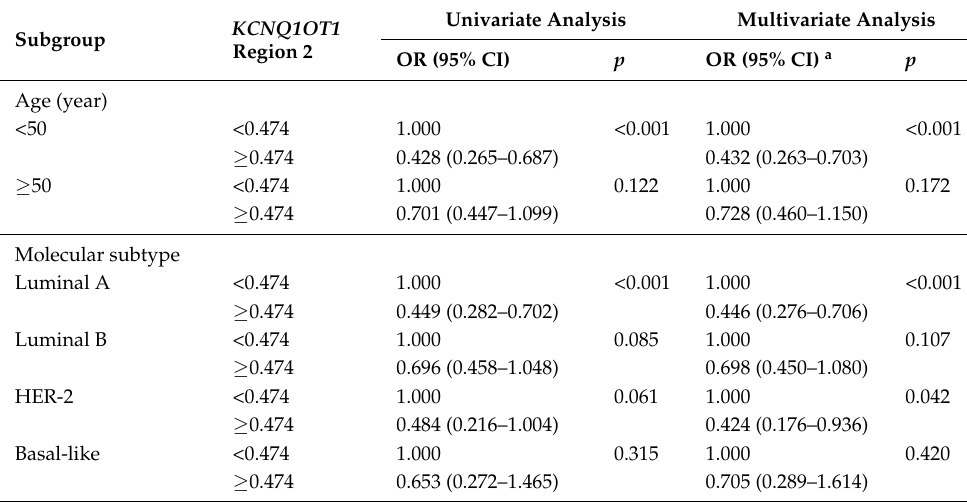
Table 3. The association between KCNQ1OT1 region methylation and the risk of breast cancer in different